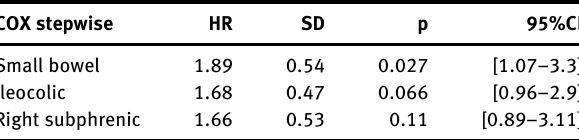
Table  : Stepwise analysis on Hazard Ratios. Independent variables.